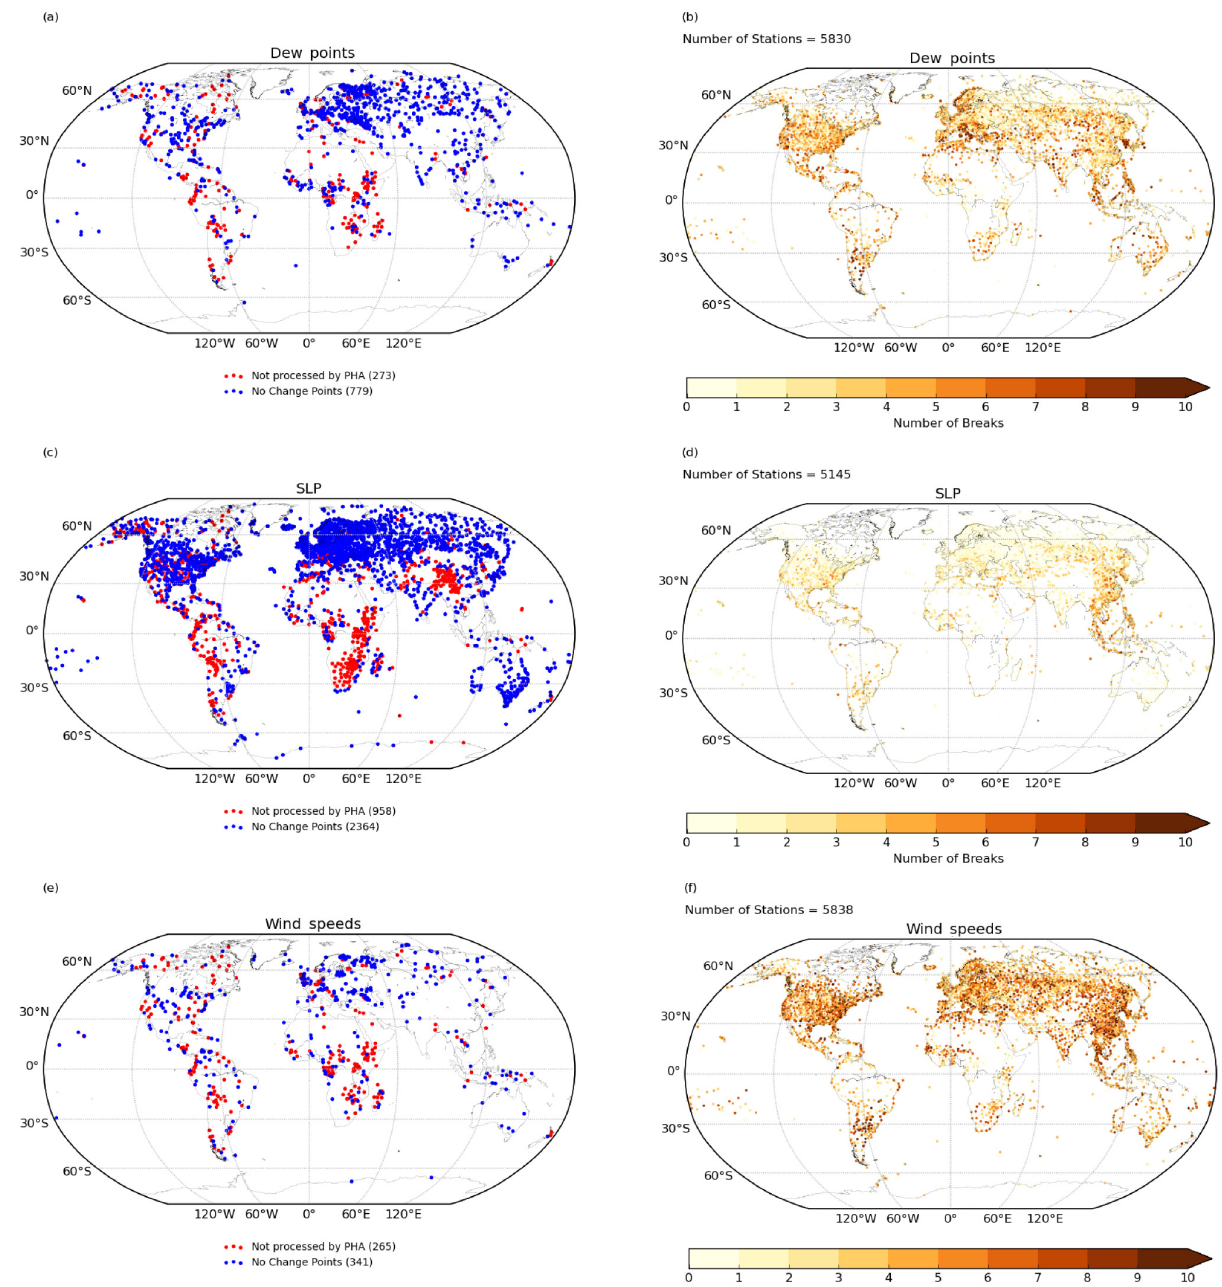
Figure 11. (a, c, e) The location of stations which could not be processed by PHA (red) and those stations where no change points were found in the entire record (blue) for (a) dew points, (c) SLP and (e) wind speeds. (b, d, f) The number of breaks detected for each station.